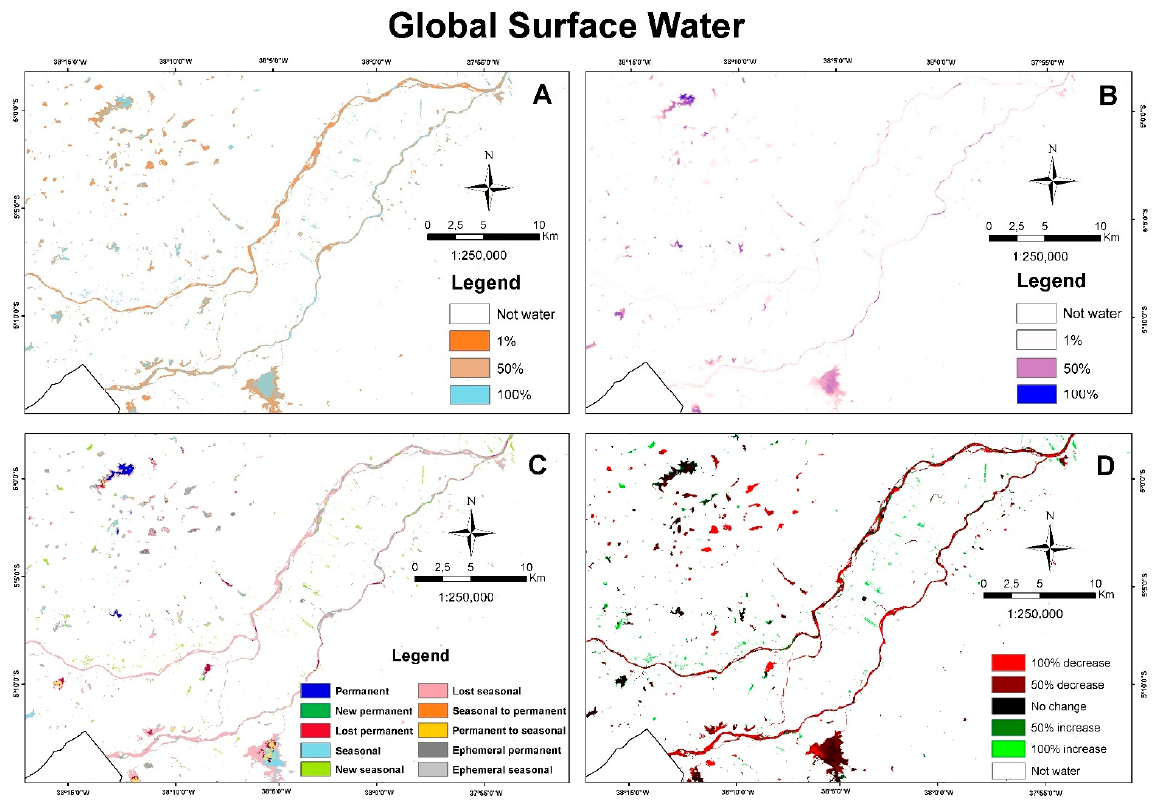
Figure 9. Surface water maps in the LJRSB central-southern region showing water ( A ) recurrence, ( B ) occurrence, ( C ) transition, and ( D ) change intensity.